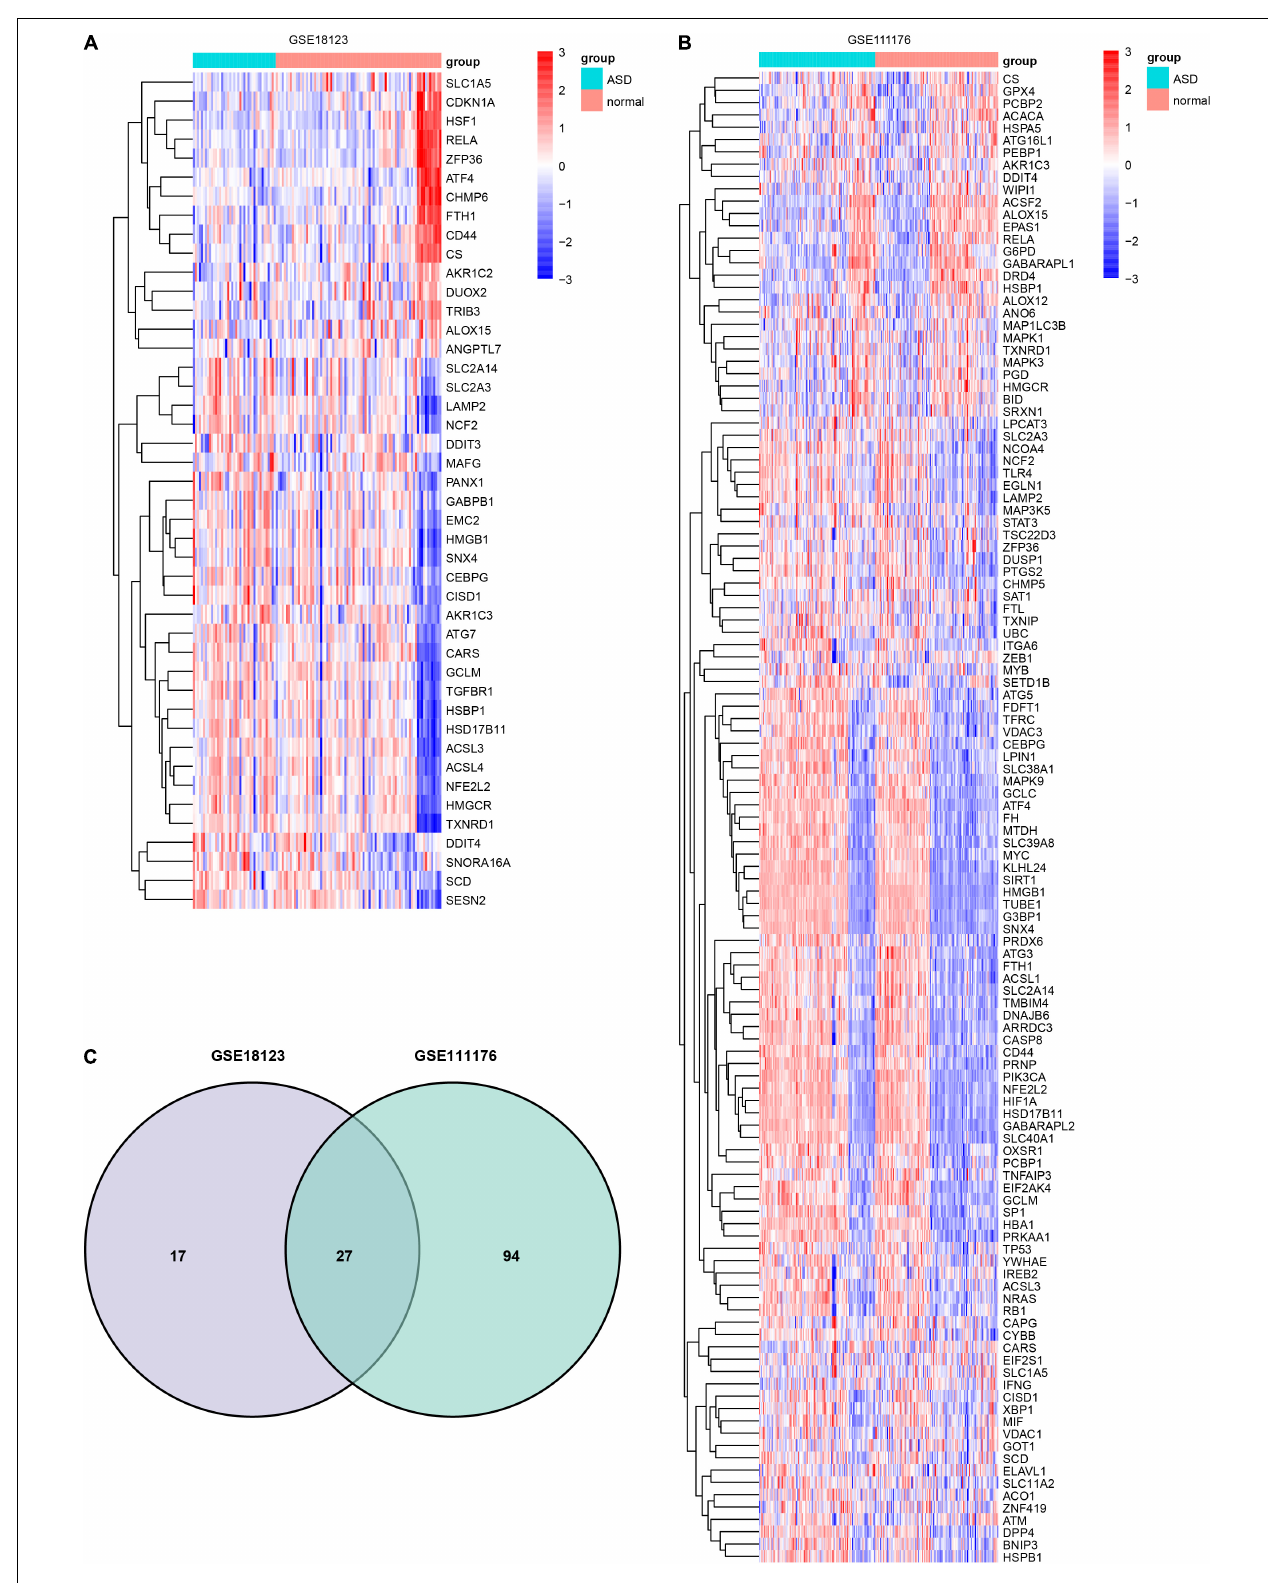
FIGURE 1 | Identification of DEFRGs. Heatmap of DEFRGs from GSE18123 (A) and GSE111176 (B) . (C) Venn diagram for DEFRGs.